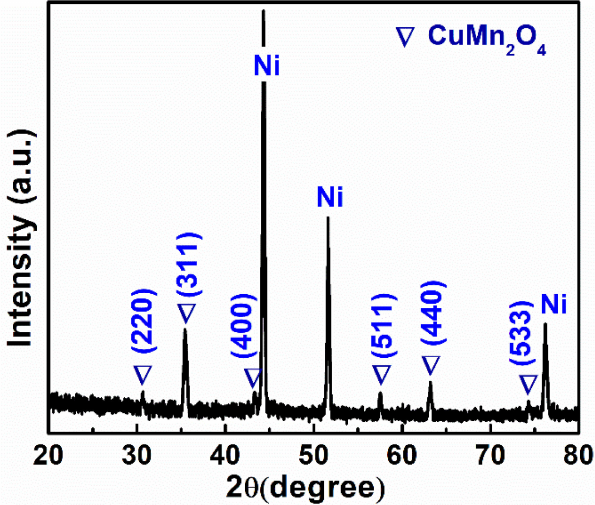
Figure 1. CuMn 2 O 4 NSA’s XRD pattern on the surface of Ni